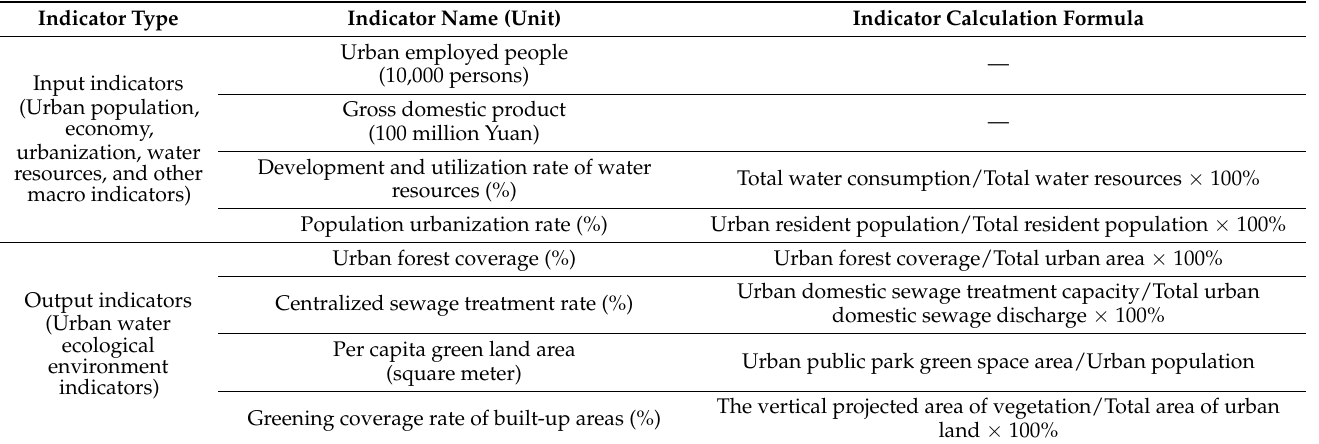
Table 1. Efficiency evaluation indicators system of